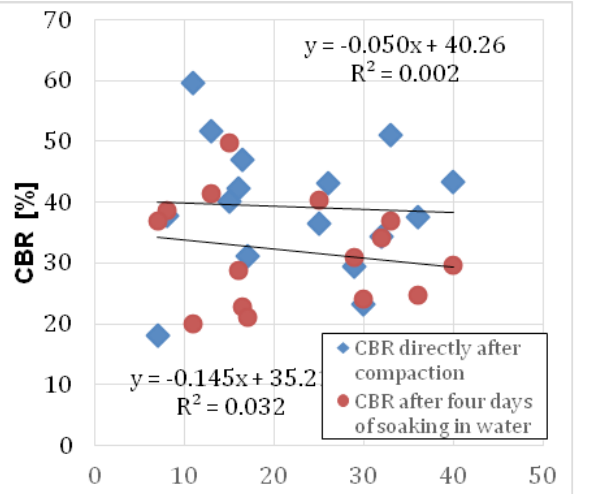
Figure 5: Correlation between CBR value and uniformity coefficient C value. U